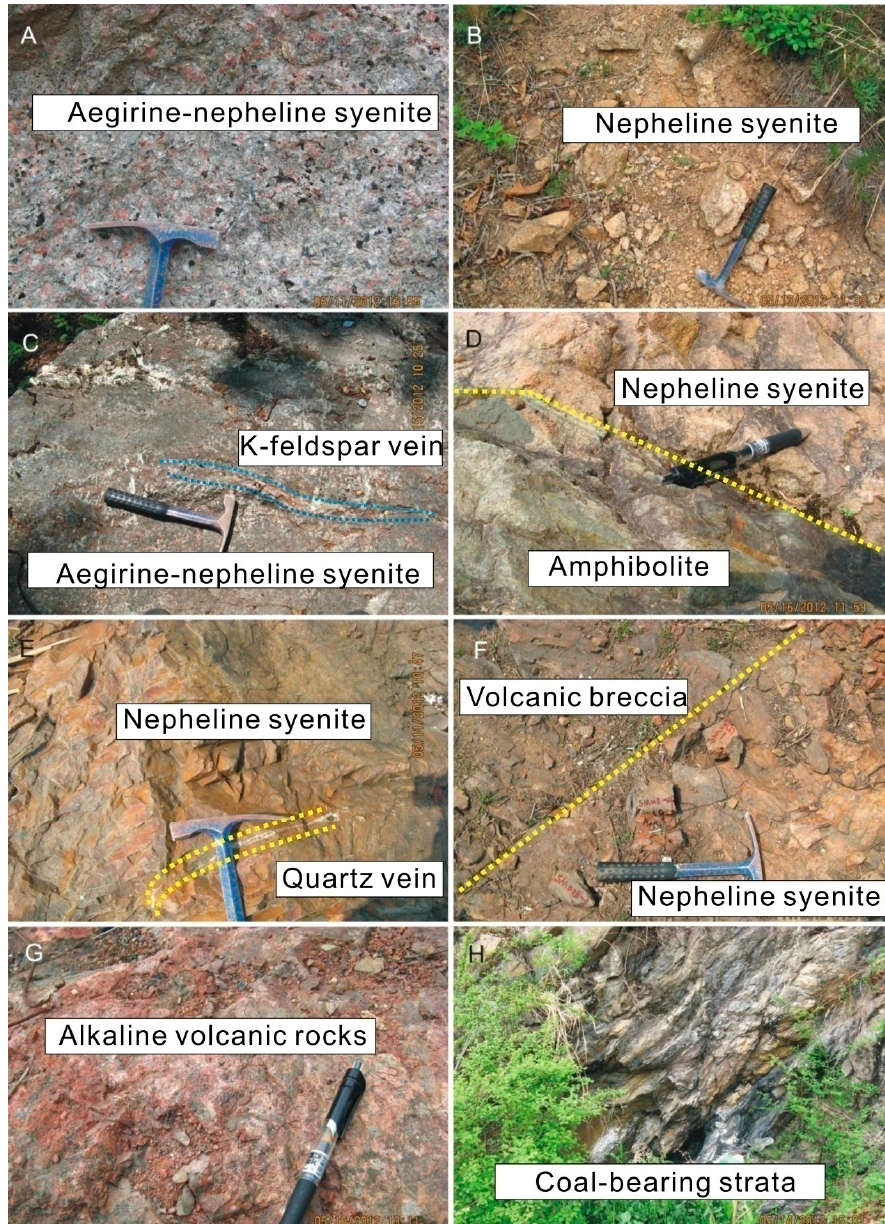
Figure 3. Field photographs of Bailinchuan alkaline complex. ( A ) Coarse grain aegirine-nepheline syenite; ( B ) An out crop of nepheline syenite; ( C ) K-feldspar vein occur in aegirine-nepheline syenite; ( D ) The contact zone between amphibolite and alkaline syenite; ( E ) Carbonate veins occur in nepheline syenite; ( F ) The contact zone between volcanic breccia and alkaline syenite; ( G ) Alkaline volcanic rock; ( H ) An out crop of coal bearing strata.